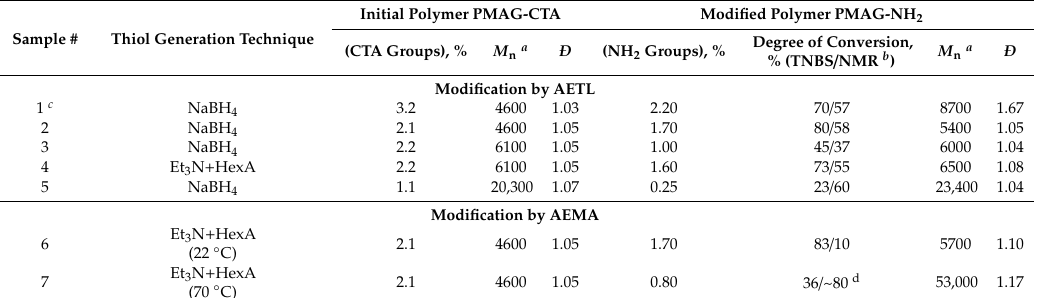
Table 2. Characteristics of the initial PMAG-CTA and modified PMAG-NH 2 homopolymers.